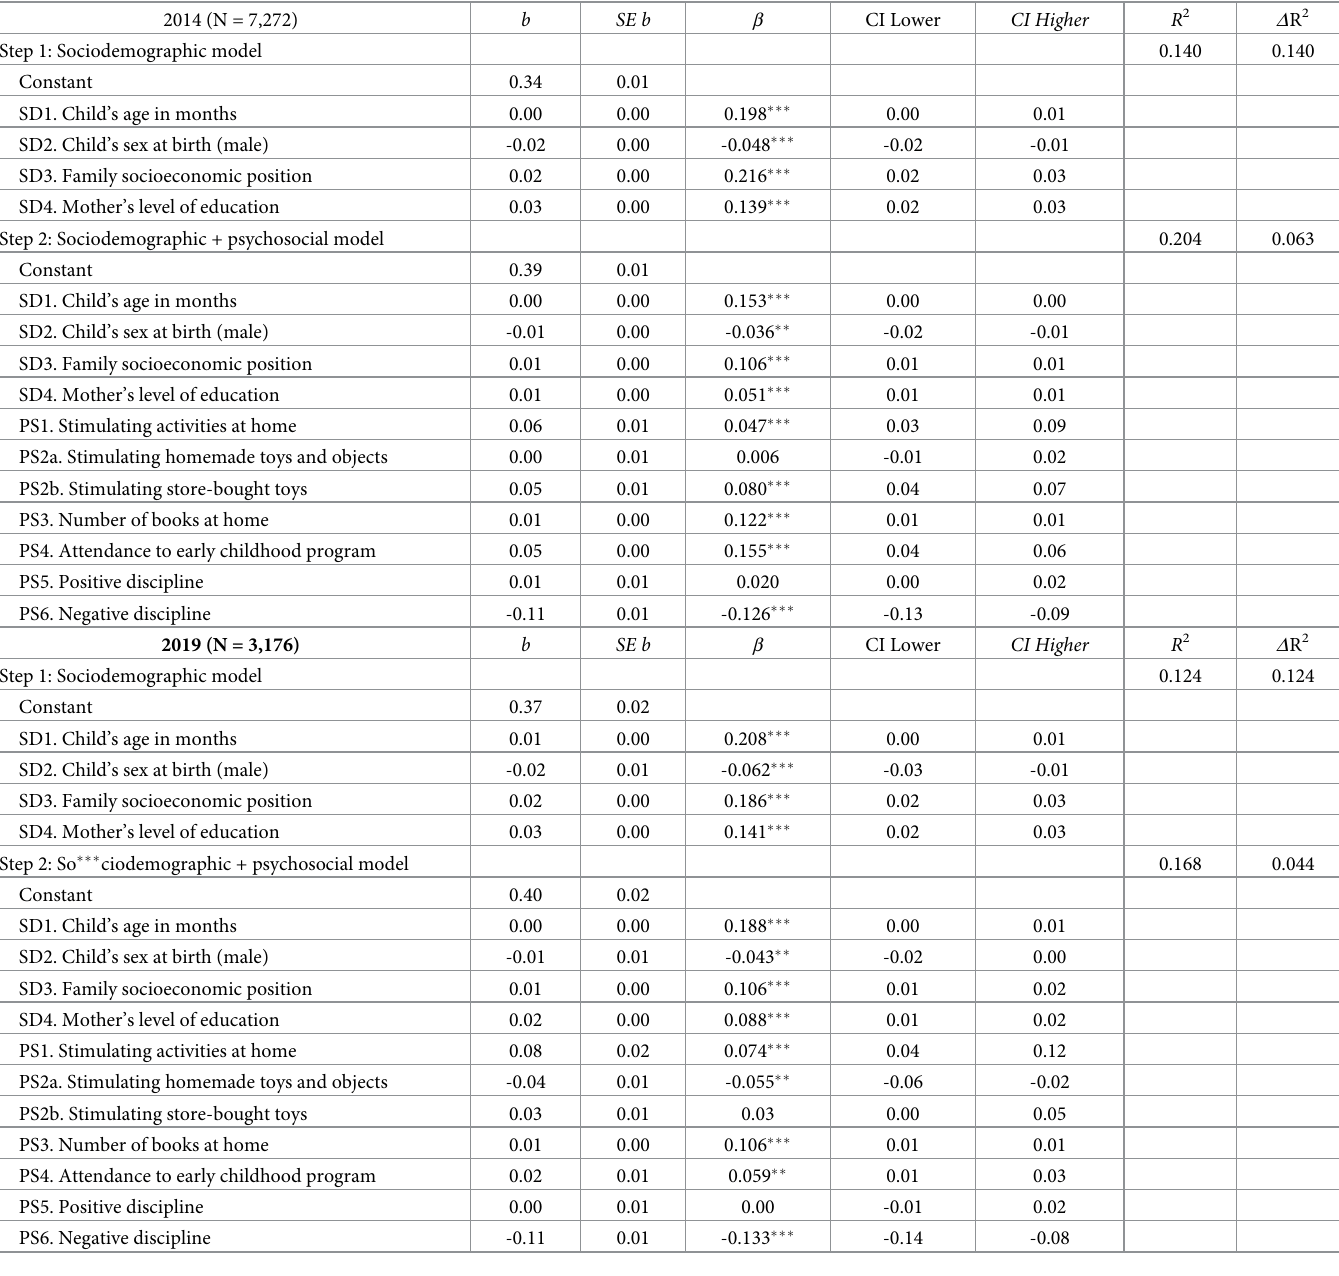
Table 4. Summary of hierarchical regression analysis for variables predicting early childhood development, MICS Dominican Republic 2014 and